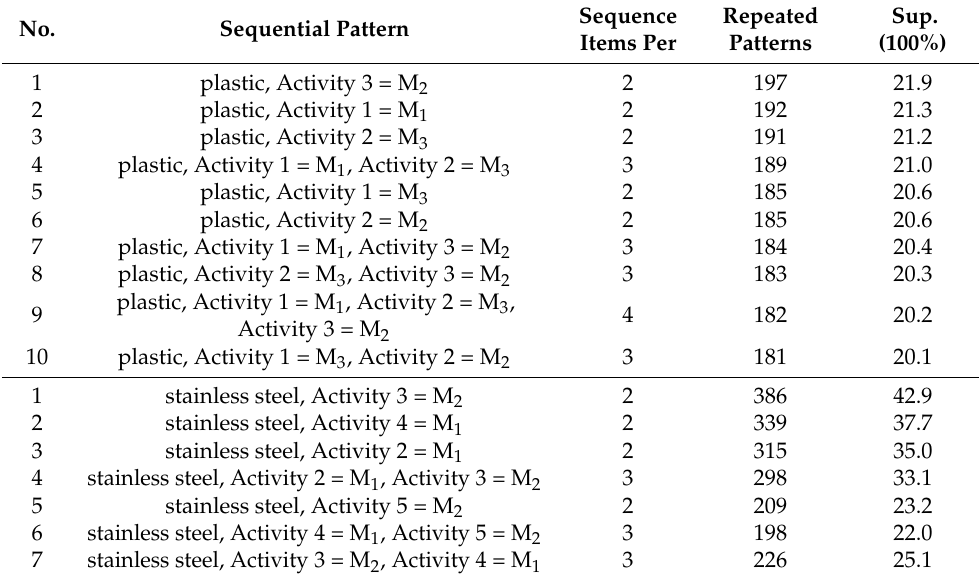
Table 13. Frequent sequential patterns for attributes of drum material.